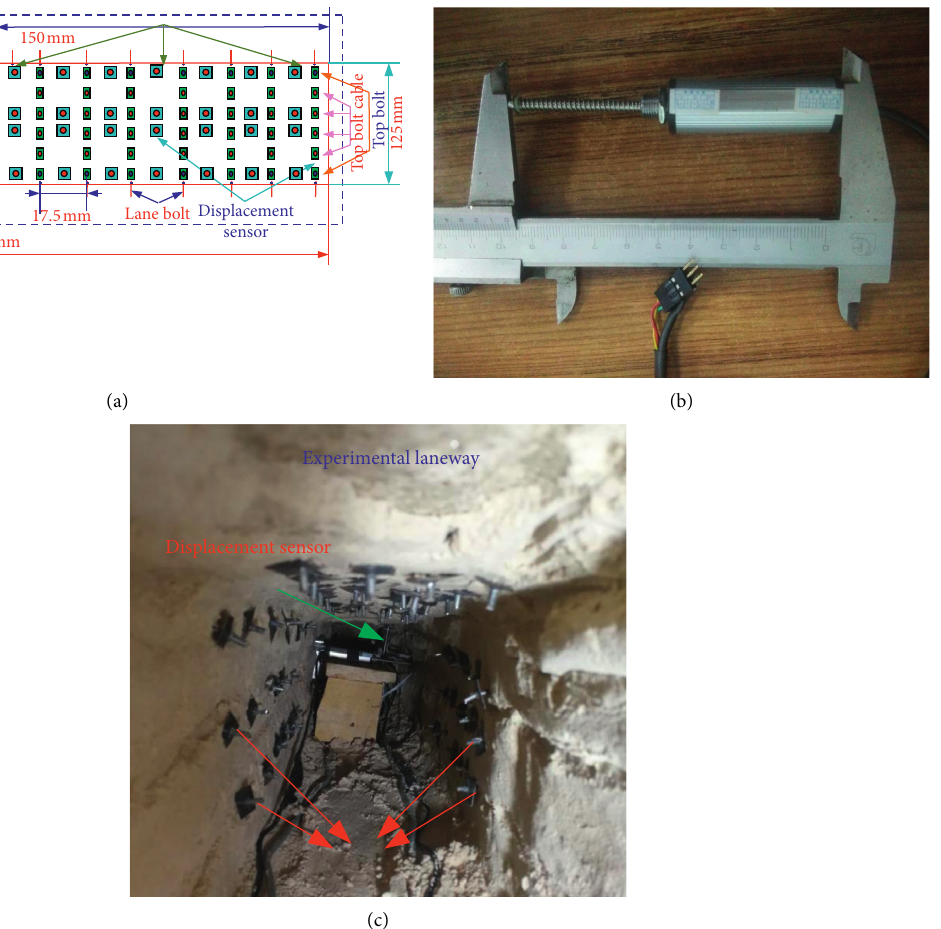
Figure 9: Simulated bolts (cables) arrangement and sensor arrangement in the experiments. (a) Simulation experiment sensor arrangement. (b) The displacement sensor. (c) Bolts (cables) layout of simulated experimental